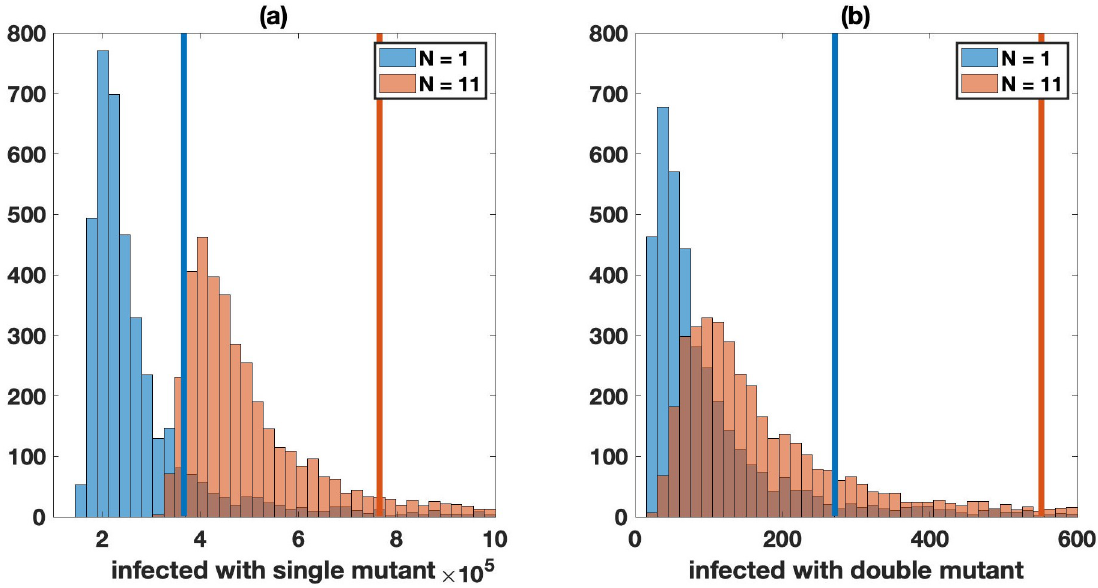
Fig 2. Neutral mutant evolution in the absence of synaptic transmission, comparing simulations with single infection only ( N = 1, blue) and in the presence of multiple infection ( N = 11, red). The mean values are shown by the vertical lines (blue for single infection only and red for multiple infection). For both panels, the Kolmogorov-Smirnov test between the two cases gives a p -value less than 10 − 6 . A Number of cells infected with one of the single mutant strains. The average for single infection is approximately 3.7 × 10 5 and for multiple infection is approximately 7.6 × 10 5 . B Number of cells infected with the double mutant strain. The average for single infection is approximately 271 and for multiple infection is approximately 551. Histograms represent 4 × 10 3 hybrid simulations with size threshold M ¼ 50 . Simulations in which infections are not established (or in the rare case a simulation does not reach the infected size threshold) are discarded. Simulations are stopped when the infected cell population is close to peak infection (6 × 10 8 cells). The other parameters are similar to Fig 1 ( F wild-type = 1, F mutant = 1, μ = 3 × 10 − 5 , λ = 1.59 × 10 7 , β = 3.60 × 10 − 9 , γ = 0, a = 0.45, d = 0.016, and R 0 = 8).